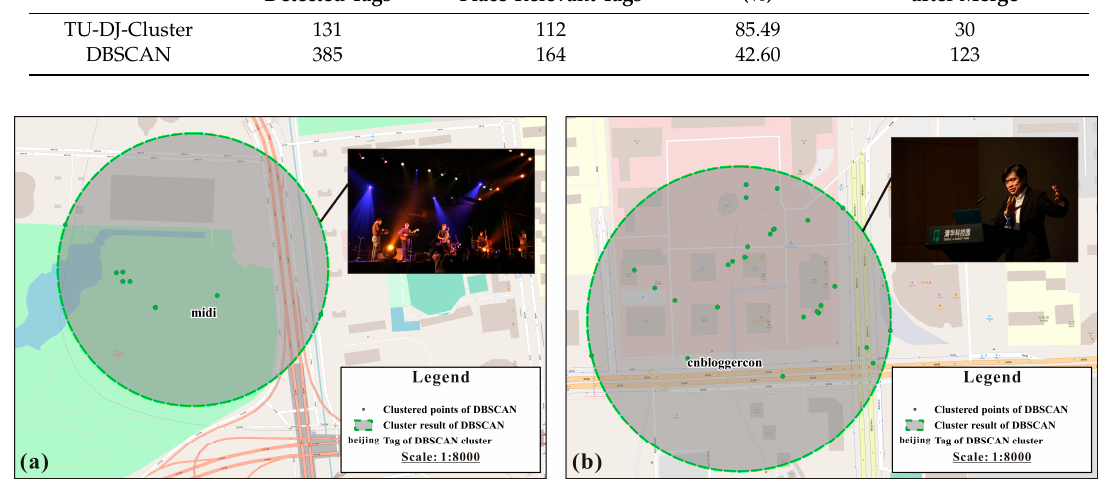
Figure 7. Some misdetection results of DBSCAN: ( a ) Midi; ( b ) cnbloggercon (The photos in